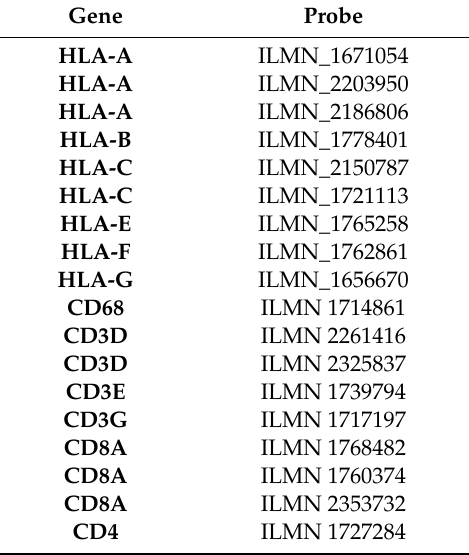
Table 5. Probes used in the